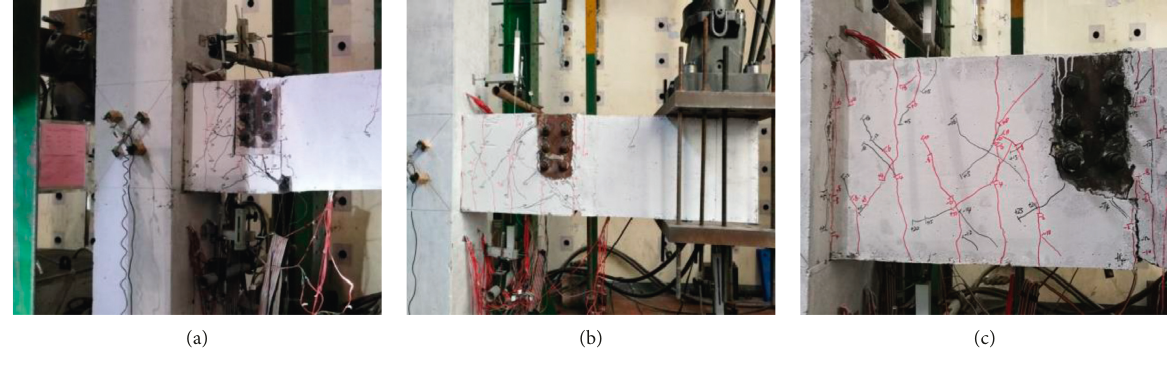
Figure 6: Crack distribution of (a) PC1, (b) PC2, and (c)